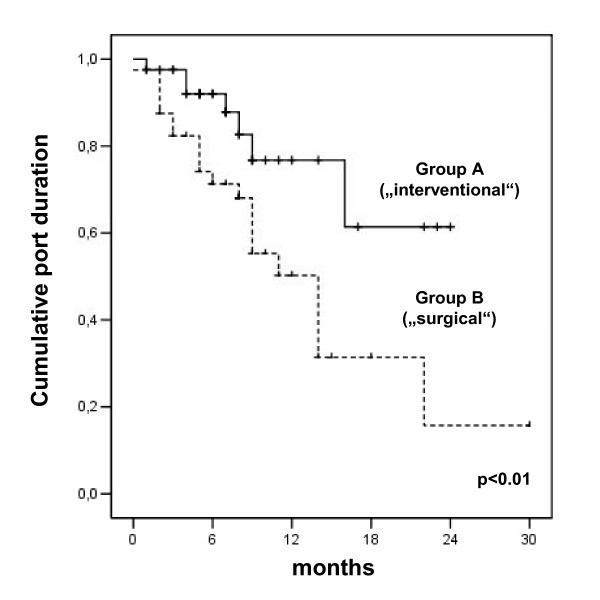
Comparison of port duration between interventionally and surgically implanted devices.